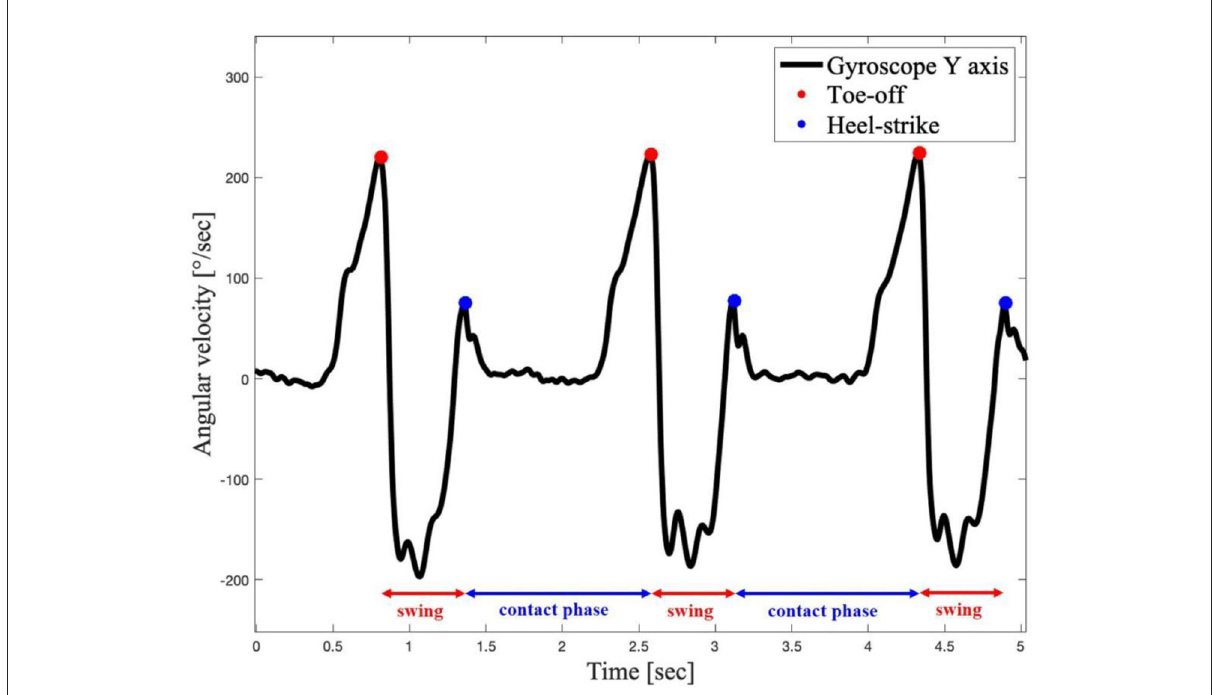
FIGURE8 Gait events of volunteer N1 performing three steps.